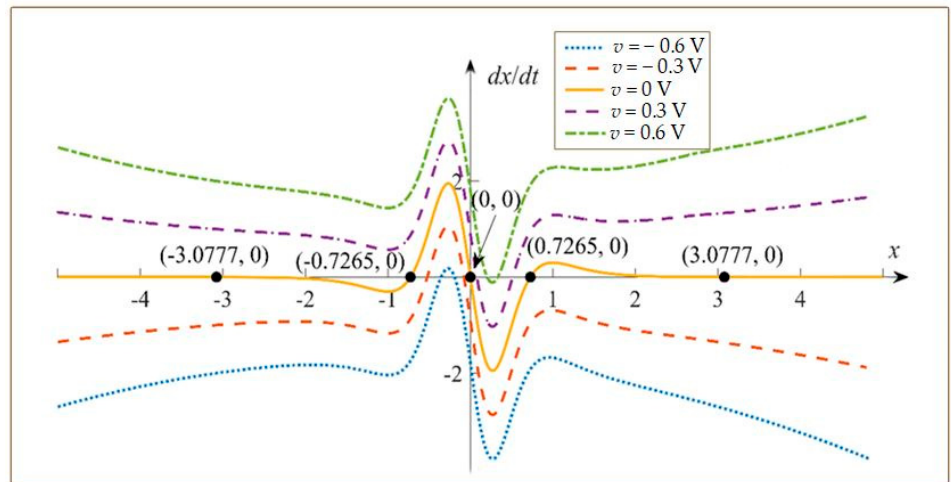
Figure 1. Dynamic route map of the memristor.